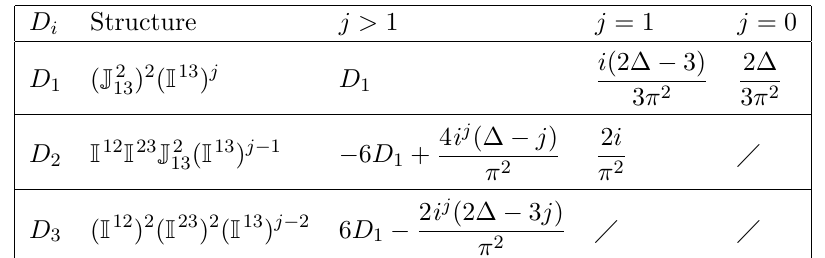
Table 5 . Ward identities of the stress tensor for the correlator We have de(cid:12)ned (cid:1) = q + (cid:22) q .